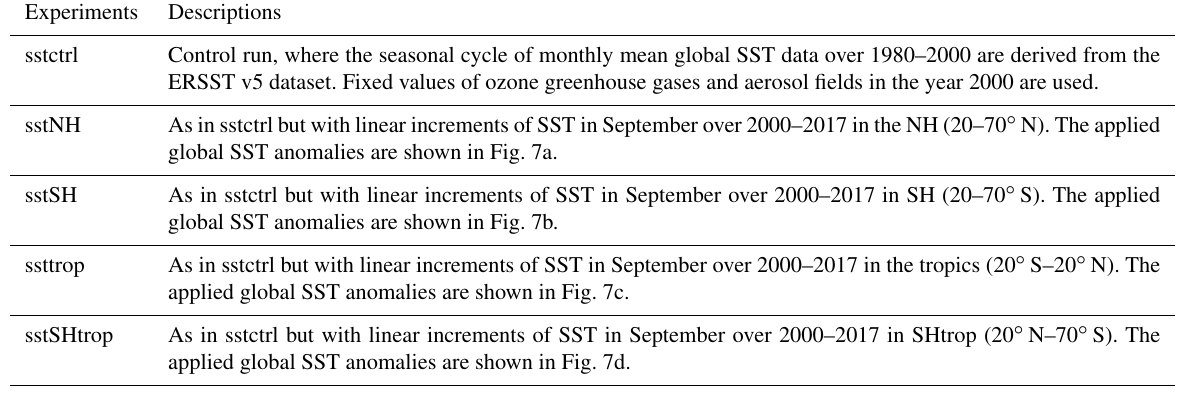
Table 1. Configurations of experiments for SST trends.